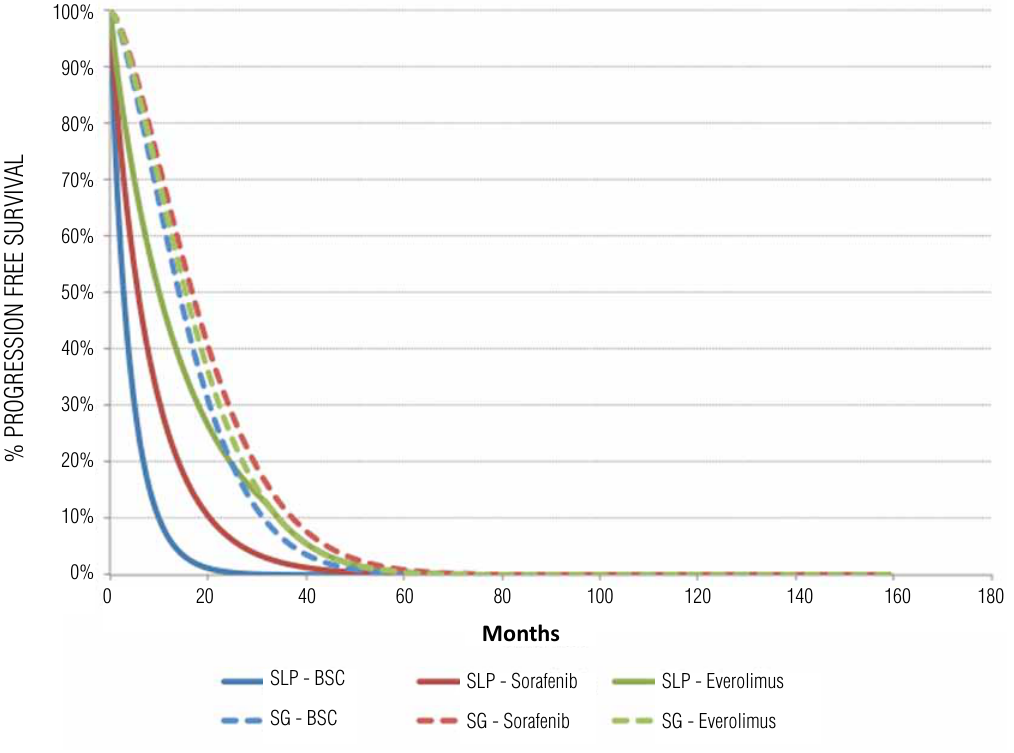
Figure 7 - Free survival progression and total survival curves for second line